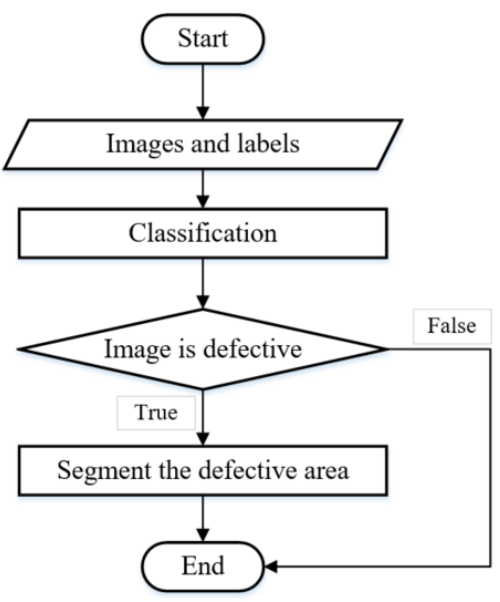
Figure 3. Flow Chart of Defects Detection System.